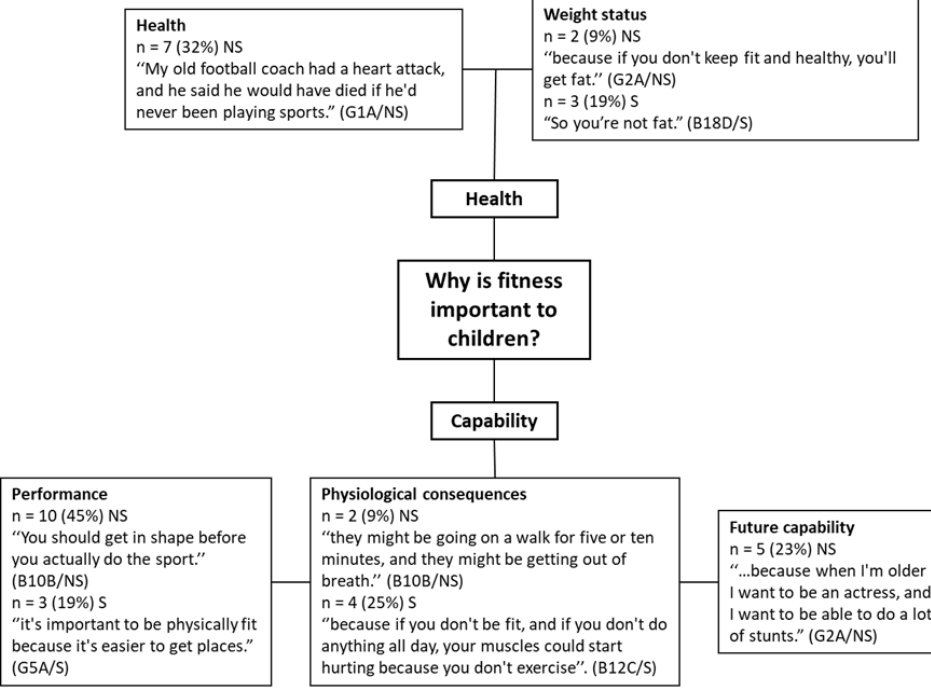
Figure 2. Pen profile showing children’s reasons why fitness is important to them. S = children from smoking households, NS = children non-smoking households. Percentages represent the proportion of each group that contributed to the theme for children from smoking ( n = 16) and non-smoking homes ( n = 22).